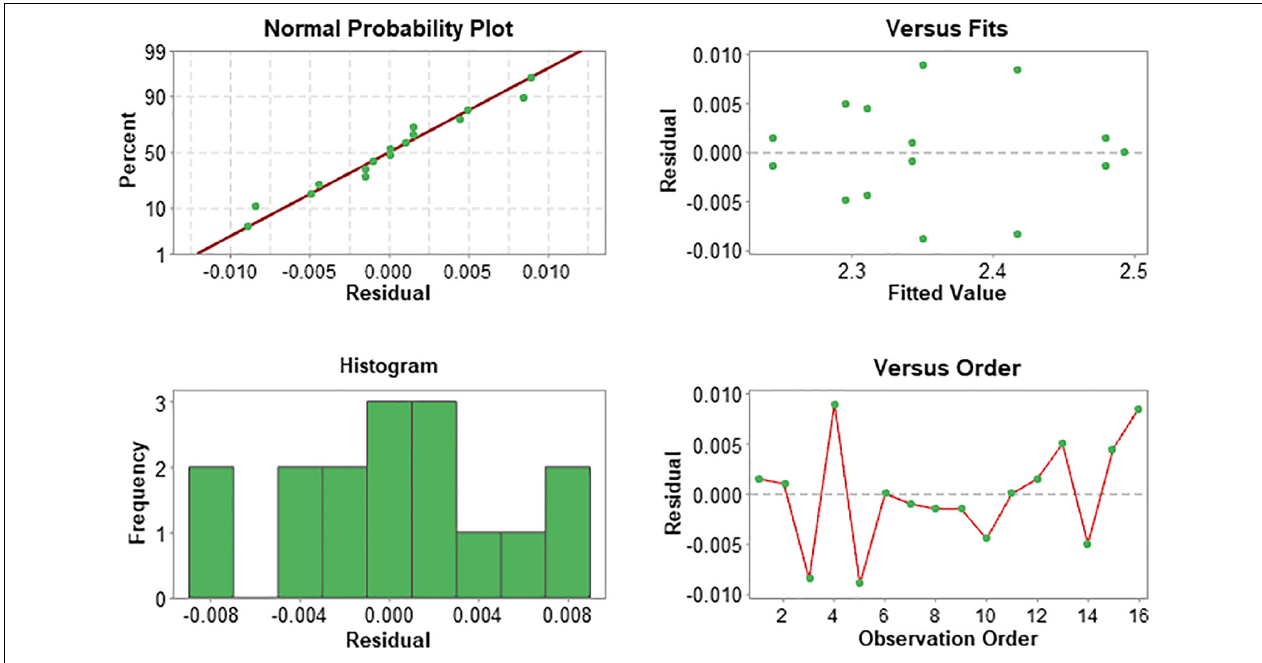
FIGURE 8 | Upper left: Normal probability plot; upper right: residual-versus-fit plot; lower left: residual histogram; lower right: residual-versus-order plot. The graphs verify the random nature of the